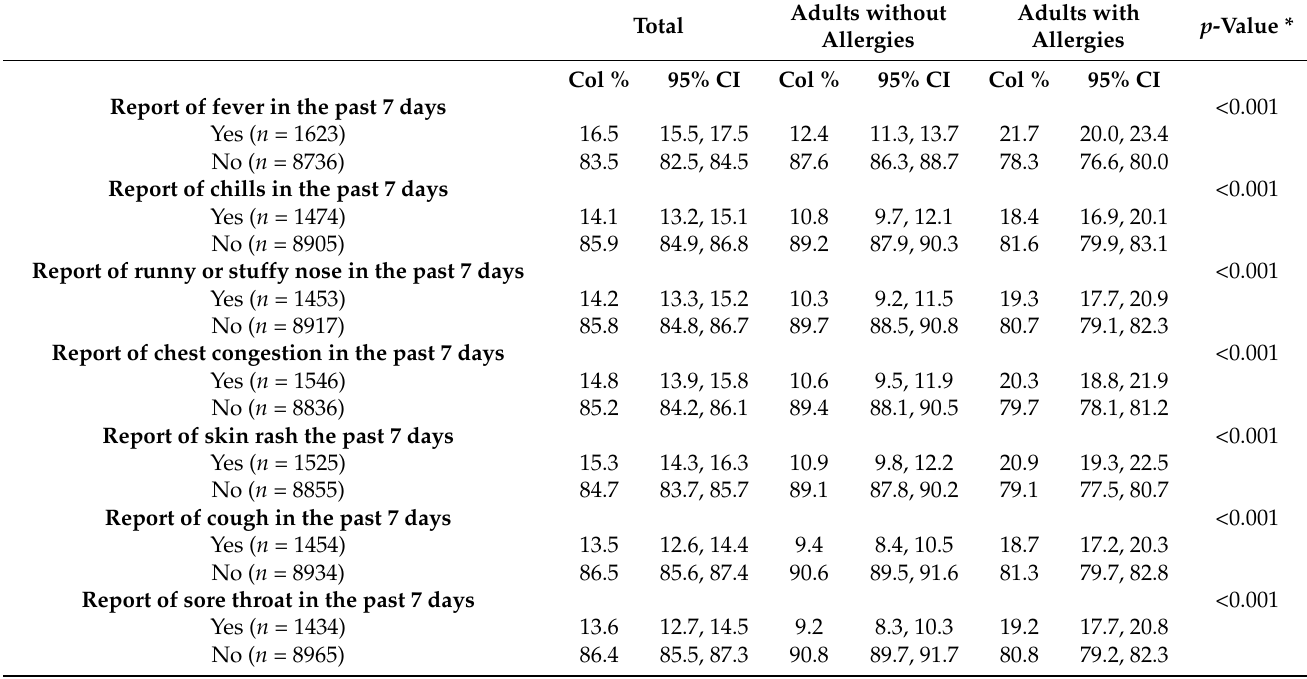
Table 2. Report of COVID-19 physical symptoms in the past 7 days among COVID Impact Survey respondents ( n = 10, 760), stratified by allergy diagnosis (April–June